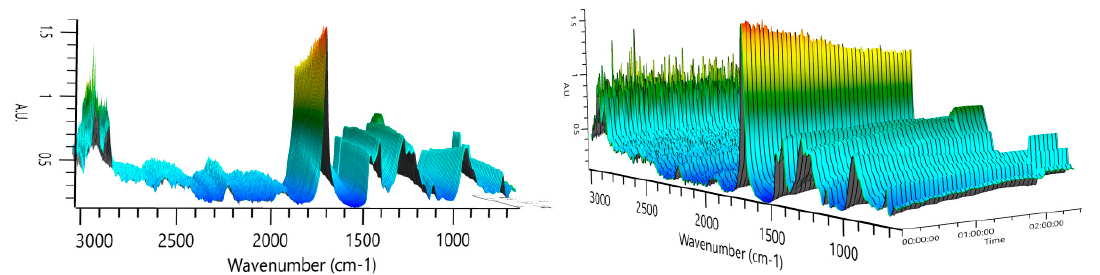
Figure 1. Synthesis temperature of amino acid-based NADESs at different molar ratios.